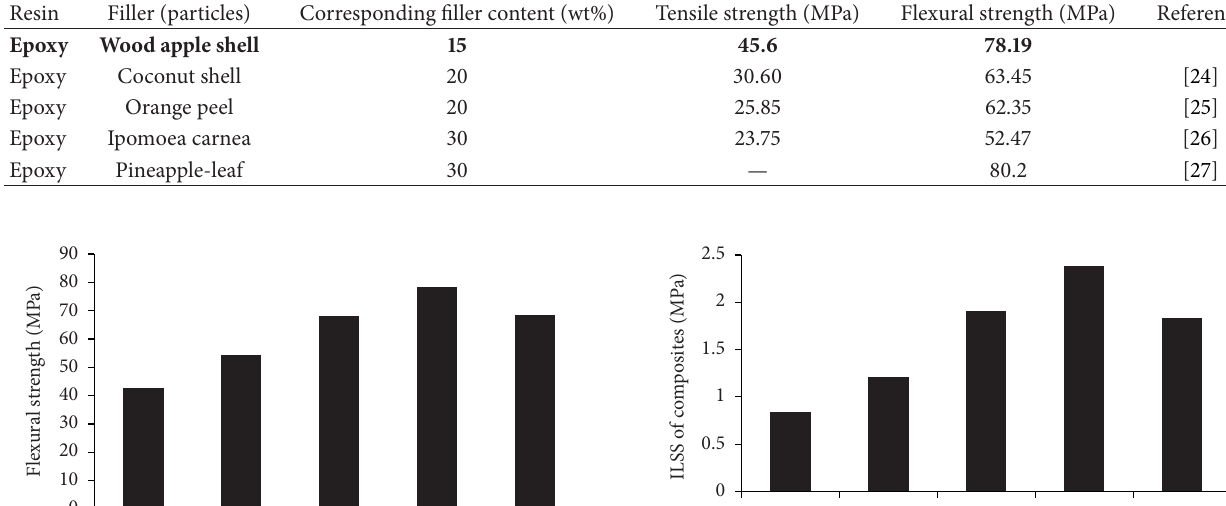
Table 6: Mechanical properties of some epoxy polymer composites.